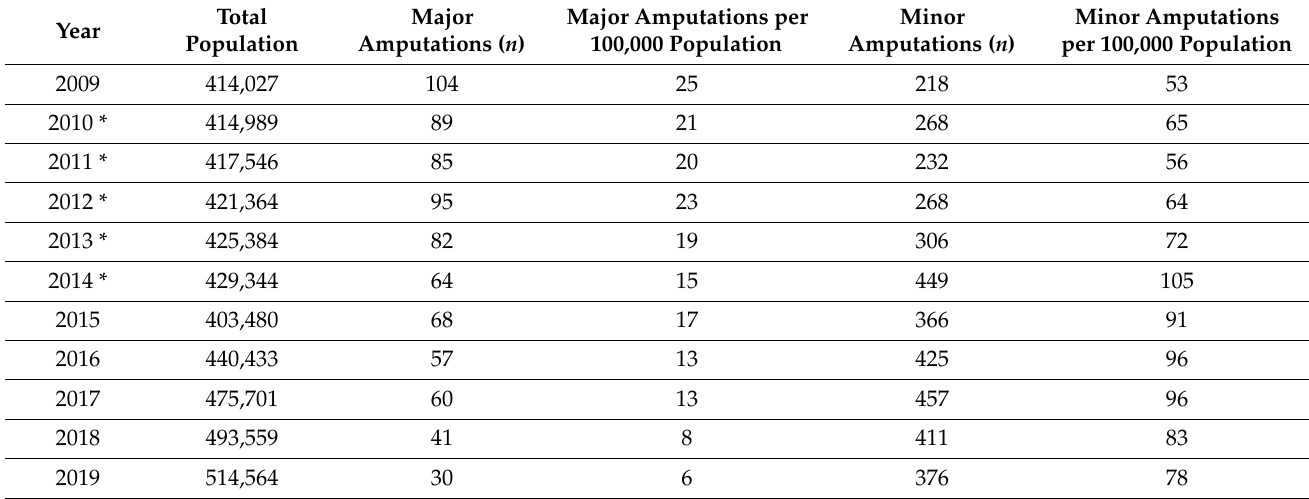
Table 2. Number of major and minor amputations in Malta from 2009 to